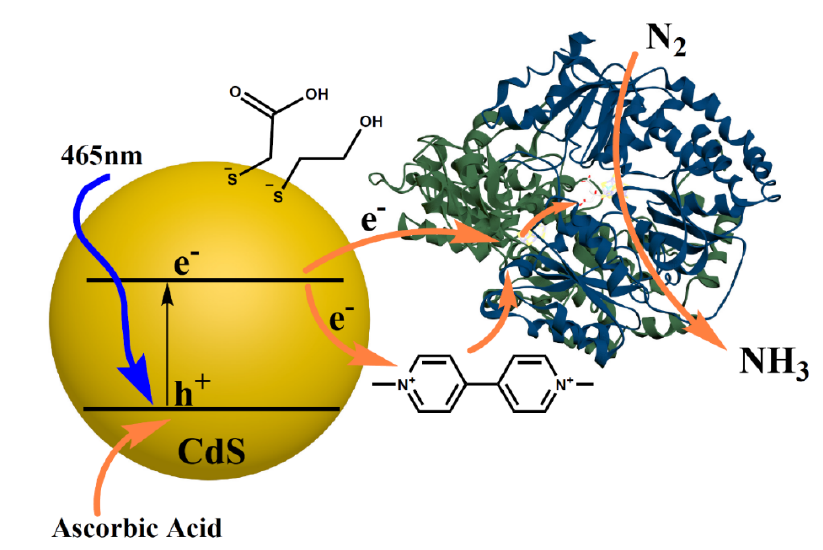
Figure 1. Schematic of the photo nano-bio hybrid systems based on CdS nanoparticles (NPs) with different ligands (2-mercaptoethanol/thioglycolic acid (ME/TGA)), viologen as a redox-active mediator, and nitrogenase (MoFe-P).